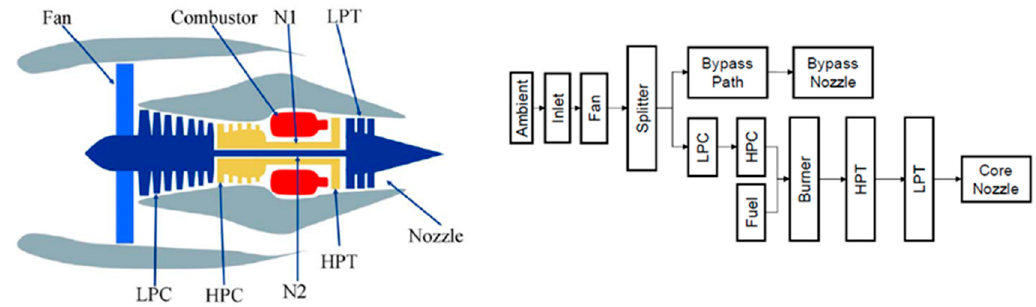
Figure 5. Engine and sensor points ( left ) and engine parts modules connections ( right ) [39].